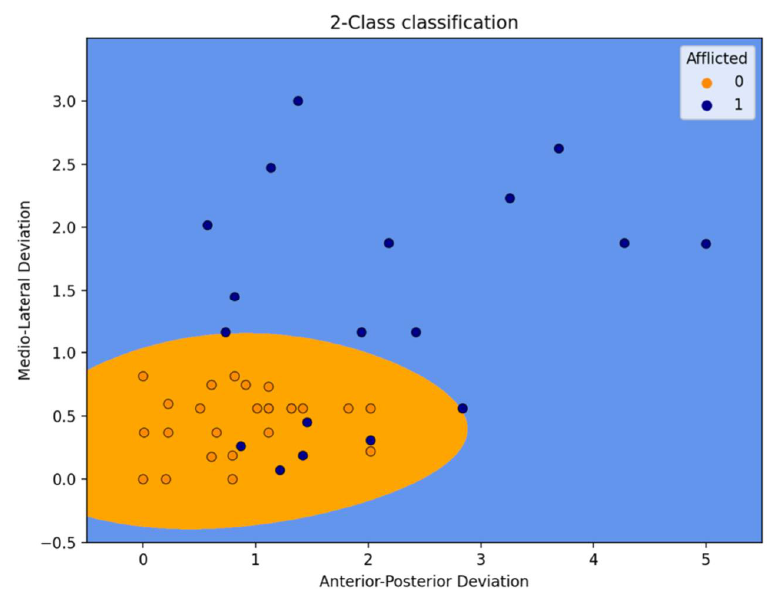
Figure 7. Prediction as seen on a graph.